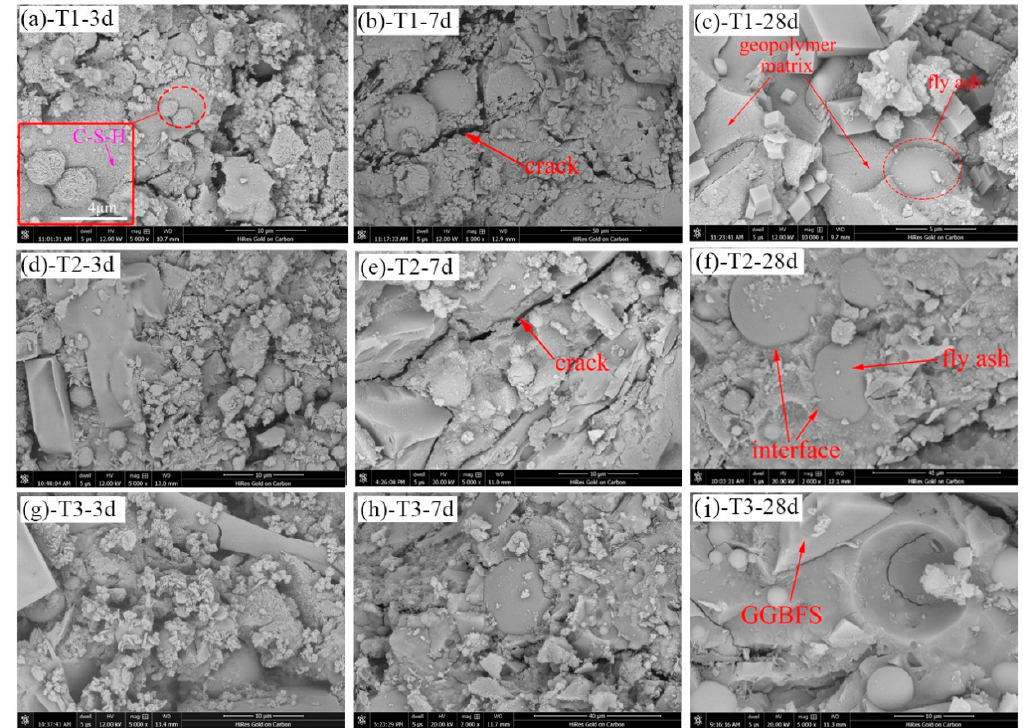
Figure 8. Micrographs of samples at different ages: ( a , d , g ) 3 days; ( b , e , h ) 7 days; ( c , f , i ) 28 days.